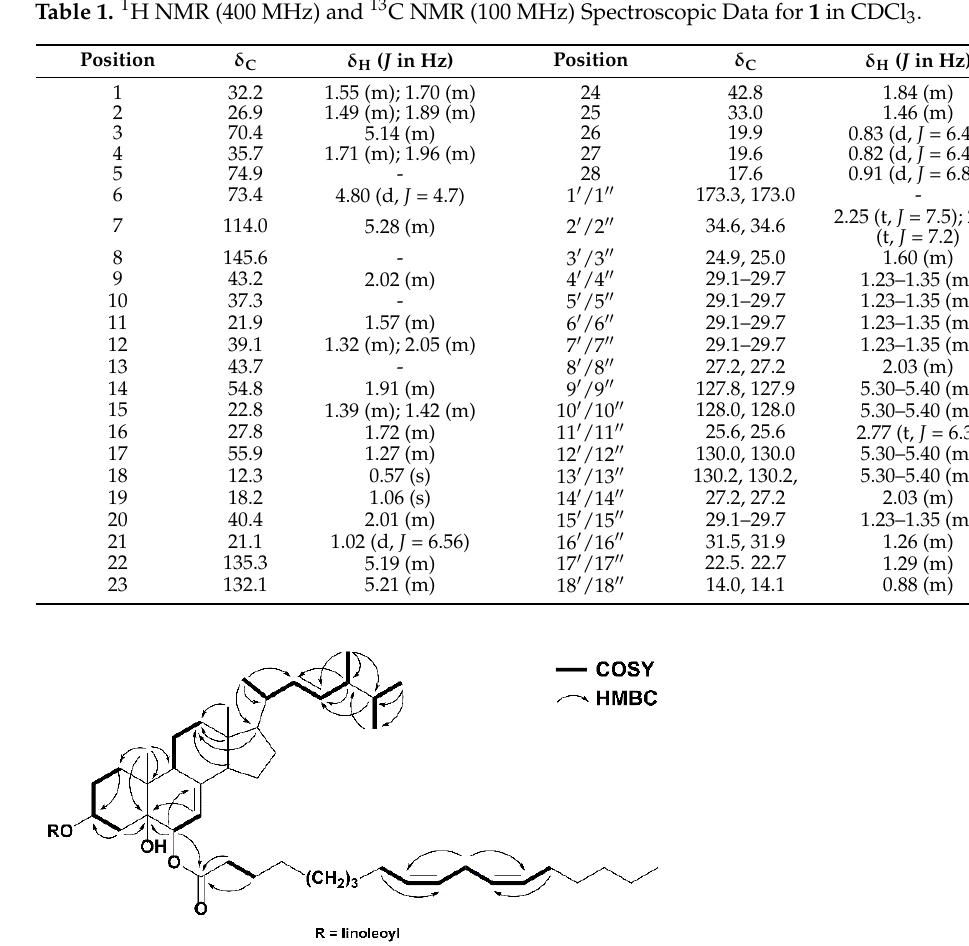
Table 1. 1 H NMR (400 MHz) and 13 C NMR (100 MHz) Spectroscopic Data for 1 in CDCl 3 .